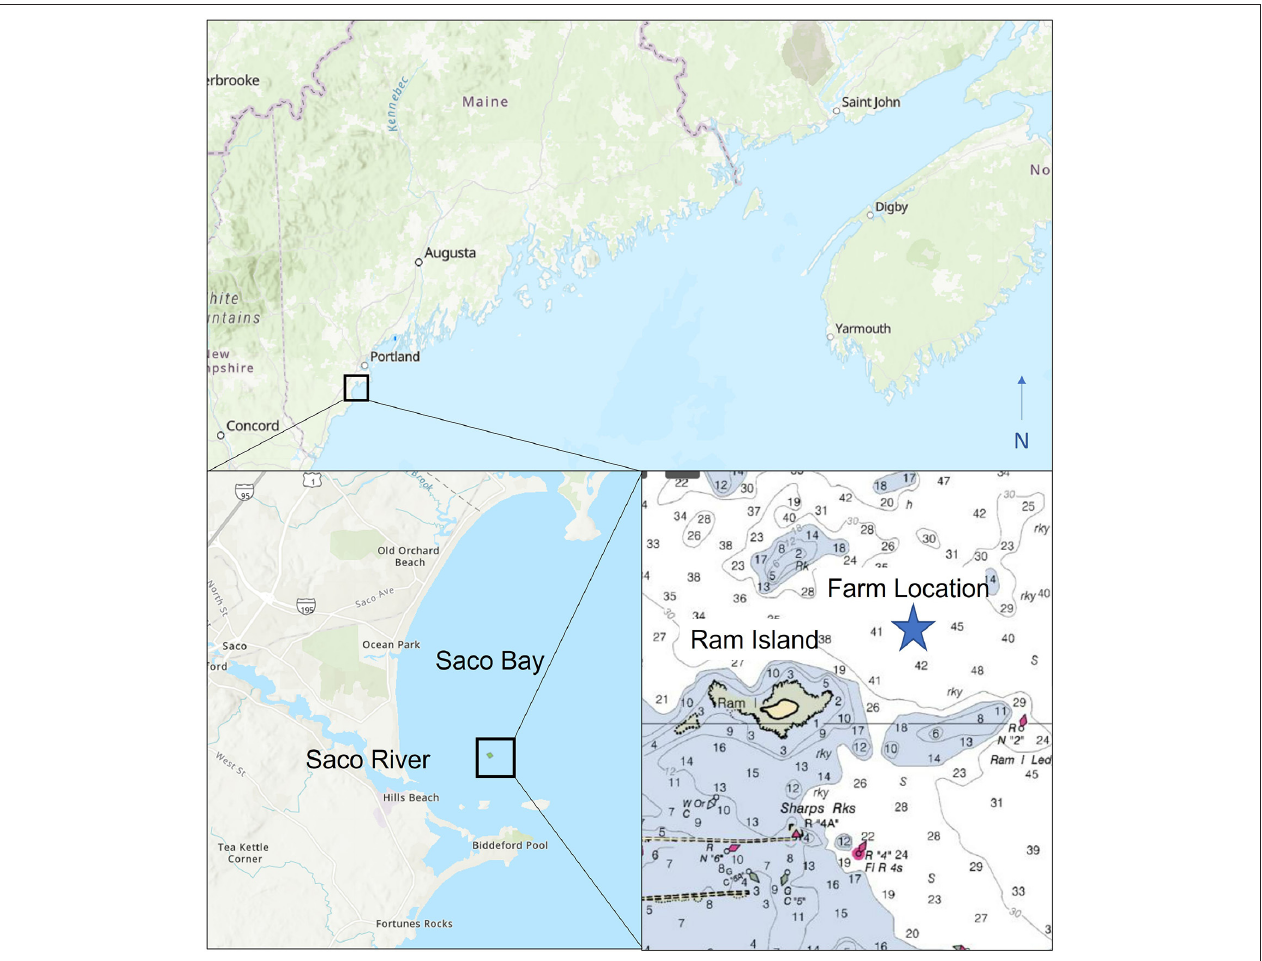
FIGURE 1 | The field study was conducted at a 0.3 by 122m LPA site in Saco Bay Maine (USA). While the site is only about 2.5km from the shore, it is completely exposed to the east.